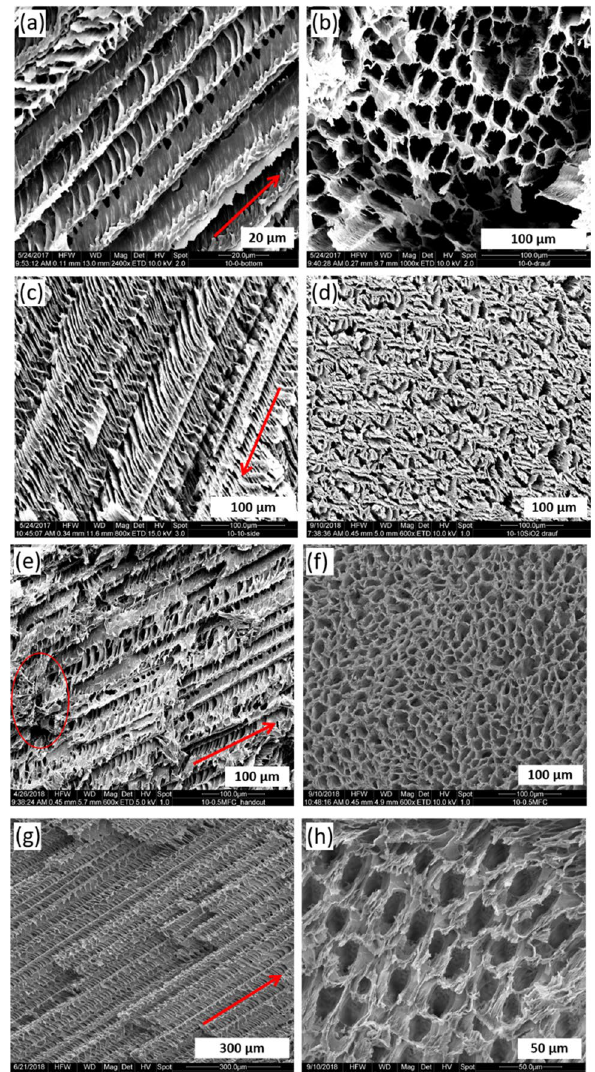
Figure 1. SEM images of the material morphologies: parallel and cross cuts. All materials were prepared using 10 wt.% PVA. Red arrows represent the freezing direction. ( a ) and ( b ) pure PVA, ( c ) and ( d ) SiO 2 /PVA, ( e ) and ( f ) MFC/PVA, ( g ) and ( h )